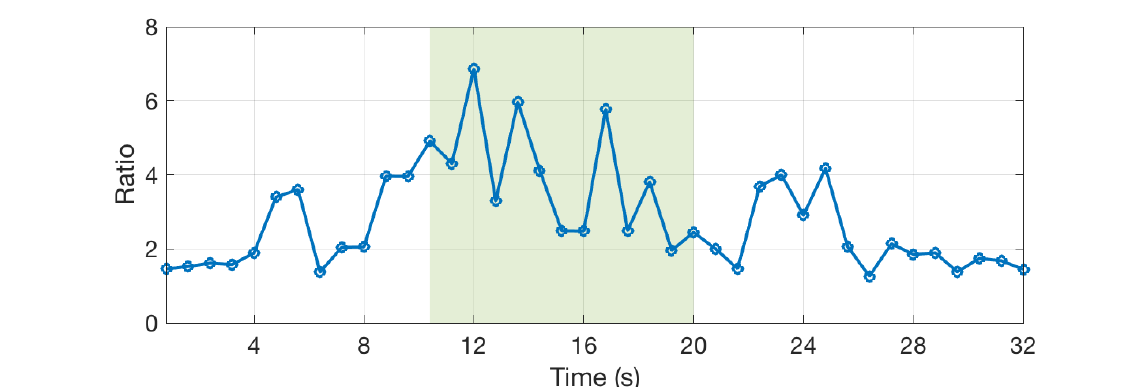
Figure 10. Ratio of spectrum amplitudes for each spectrogram